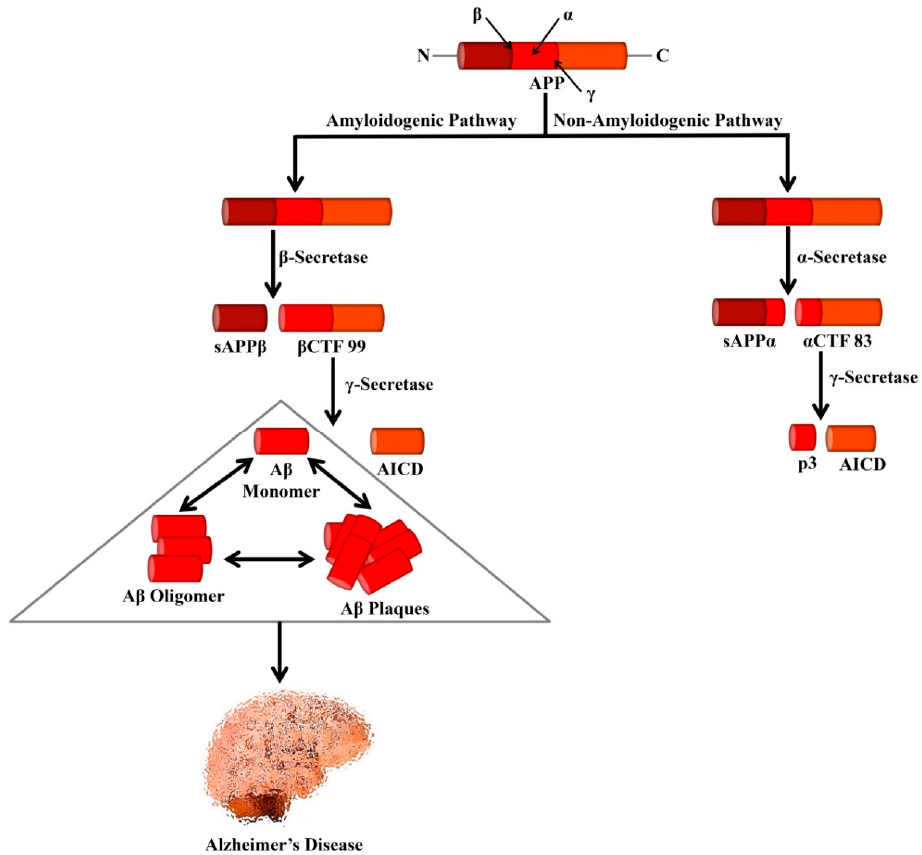
Figure 1. Processing of APP by secretases that leads to the formation of Alzheimer’s-associated A β peptides. In the amyloidogenic pathway, APP is cleaved by β - and γ -secretases leading to the formation of A β peptides and AICD. Formation of the neurotoxic A β is the major cause of AD. In the non-amyloidogenic pathway, APP is cleaved by α - and γ -secretases leading to the genesis of p3 and AICD. APP, Amyloid precursor protein; sAPP α , Soluble APP alpha; sAPP β , Soluble APP beta; α CTF 83, Alpha C-terminal fragment 83; β CTF 99, Beta C-terminal fragment 99; AICD, APP intracellular domain.